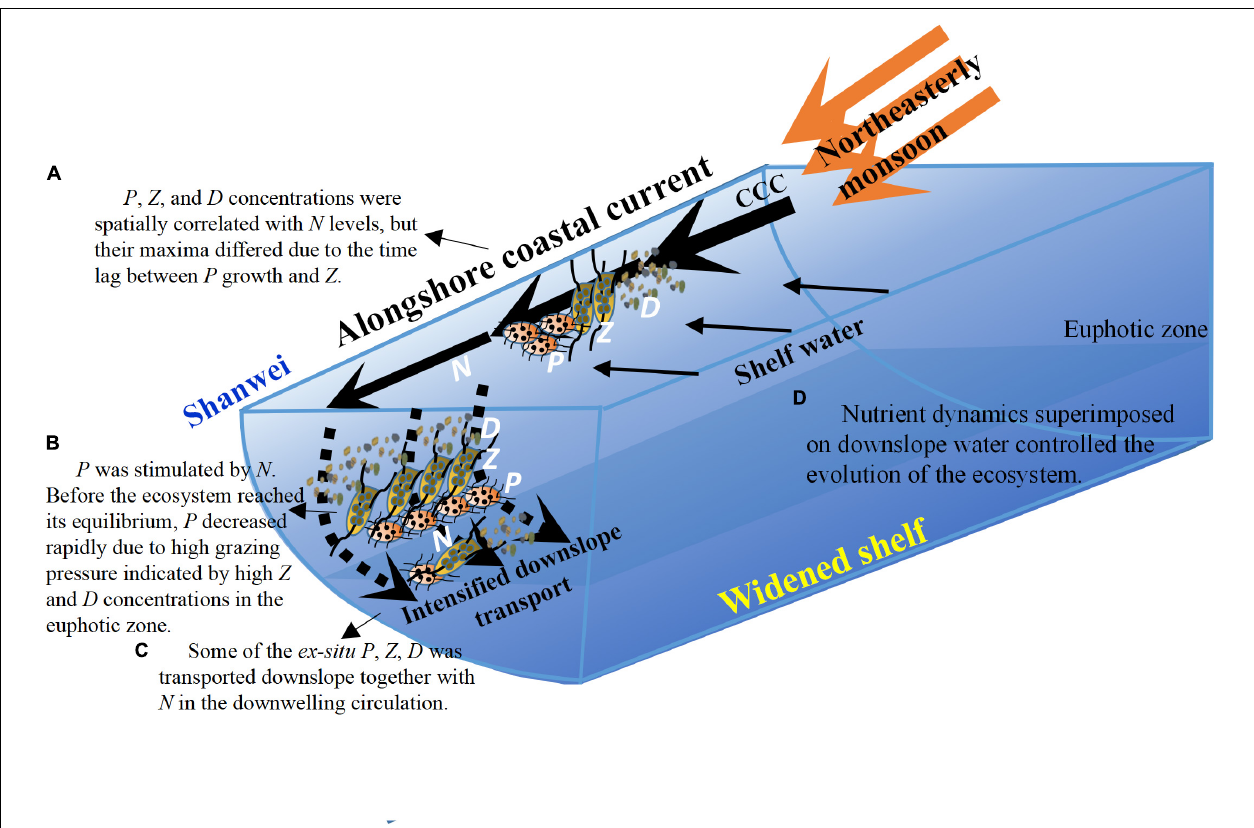
FIGURE 12 | Schematic diagram showing the responses of nutrient transport and associated biological processes to the intensified downwelling-favorable wind over the widened NSCS shelf. N , P , Z, and D stand for nitrogen, phytoplankton, zooplankton, and detritus, respectively. (A–D) List the key biophysical